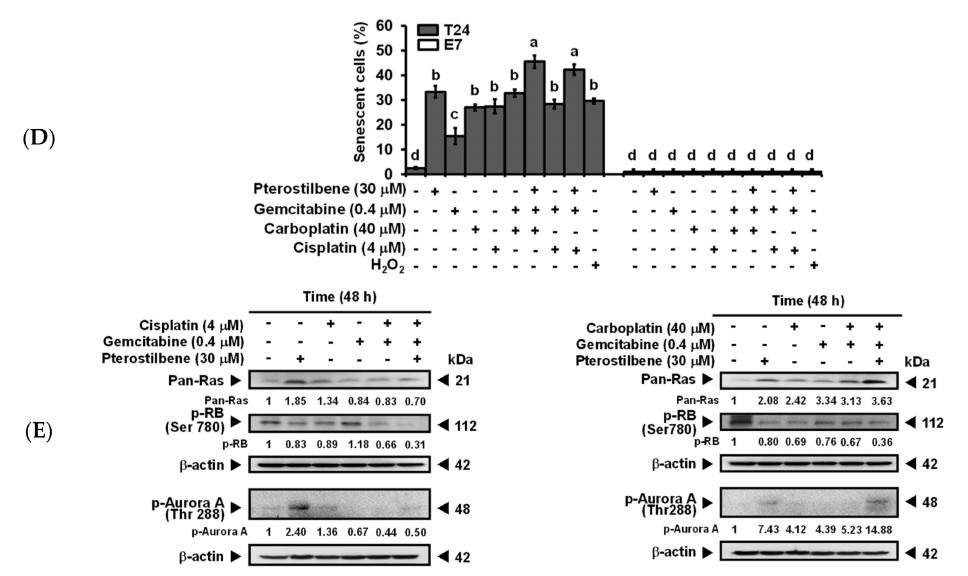
Figure 5. Pterostilbene induced the cytotoxic form of autophagy and enhanced senescence on T24 cells. ( A ) E ff ect of autophagy inhibitors on the population growth of T24 cells. T24 cells were either pretreated with U0126 for 2 h prior to the addition of the indicated concentration of compounds for 48 h, or cotreated with 3-MA and the indicated concentration of compounds for 48 h. After treatment, MTT was added to evaluate the cytotoxicity of the cells. Data of at least three independent experiments were quantified. ( B ) Induction of senescence on T24 cells. ( C ) No induction of senescence on E7 cells. ( D ) Quantification of senescence on both T24 and E7 cells. After treatment for 48 h, the activity of senescence-associated β -galactosidase was determined by the hydrolysis of X-Gal to yield a blue-colored product. The cells treated with H 2 O 2 (stress-induced senescence) [44] were used as a positive control. The number of blue-colored cells of at least three independent experiments was quantified. At least 100 cells were counted for each experiment. Data are presented as means ± SEMs. Means in each plot with di ff erent superscript letters are significantly di ff erent, p < 0.05. ( E ) Expression of Pan-RAS, p-RB, and p-Aurora-A. After treatment for 48 h, the total protein of T24 cells was subjected to Western blot analysis. Anti-pan-RAS, anti-p-RB, and anti-p-Aurora-A antibodies served as probes. β -actin served as a loading control. The intensity of each protein expression band was quantified through densitometry normalization to that of β -actin, with the control level arbitrarily set to 1. Results are representative of three independent